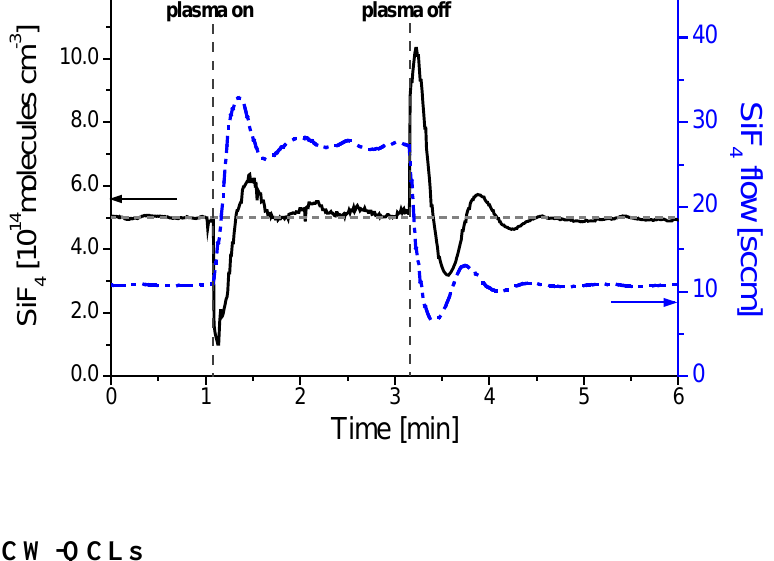
Figure 12. Stabilization of the SiF 5 × 10 14 cm -3 (dotted trace) in a SiF the feed gas flow (dash-dotted trace). (reprinted with permission from EDP Sciences (http://www.epjap.org/)